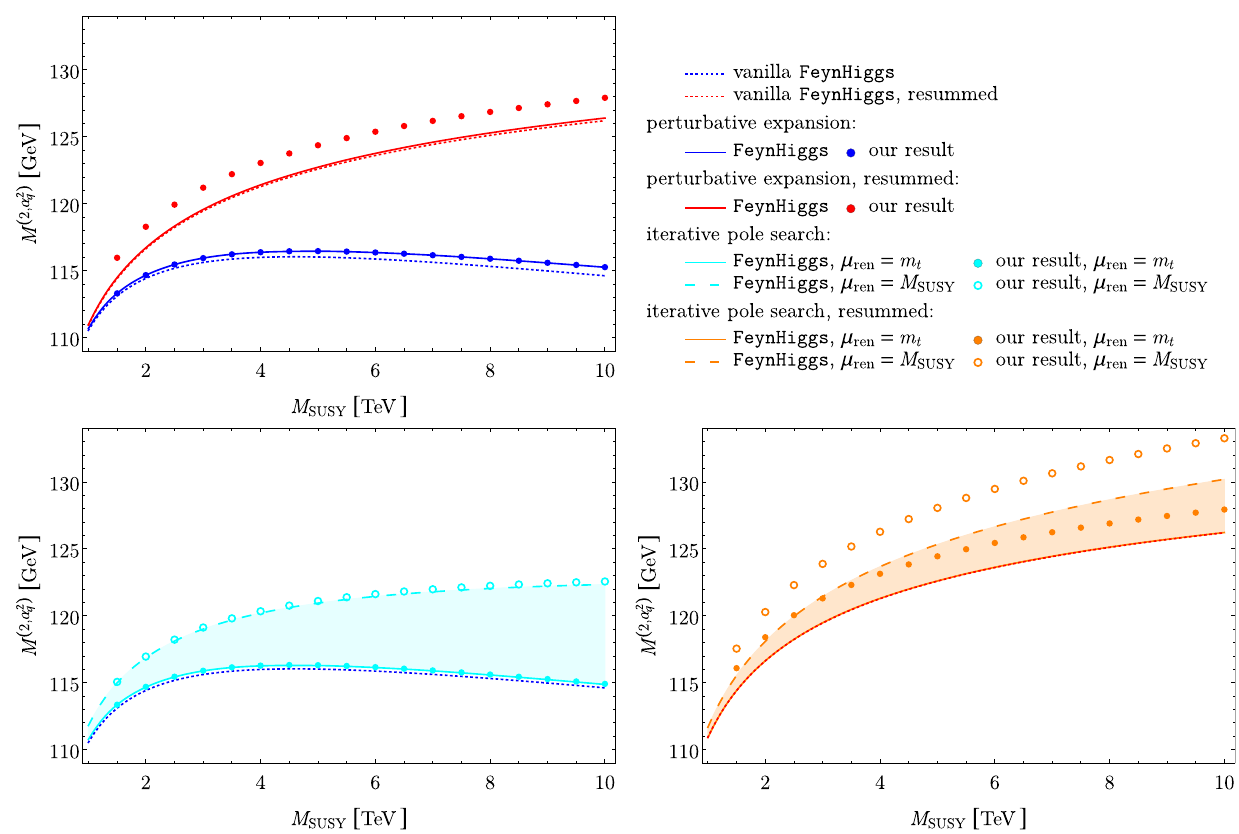
Fig. 12 Comparison of our results with those of FeynHiggs . Blue/cyan curves and symbols correspond to the mass predictions with strict FO expansion, while the red/orange ones include a resumma- tion of UV-logarithms. Actual lines refer to masses determined with FeynHiggs whereas the disks and circles proceed from our own cal- culations. The default output of FeynHiggs , ‘vanilla FeynHiggs ’, is plotted with short-dashed lines in all plots to serve as a reference. All